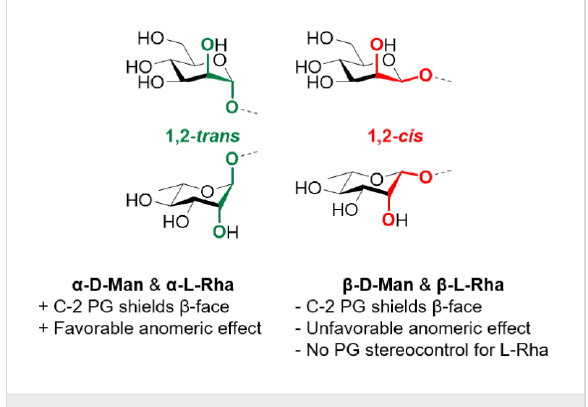
Figure 5: ‘Double-faced’ chemistry exemplified for ᴅ -Man and ʟ -Rha. Constructing β -Man linkages is considerably more challenging than constructing α -Man. β -Rha linkages present an additional challenge as PG-directed 1,2- cis glycosylations are not